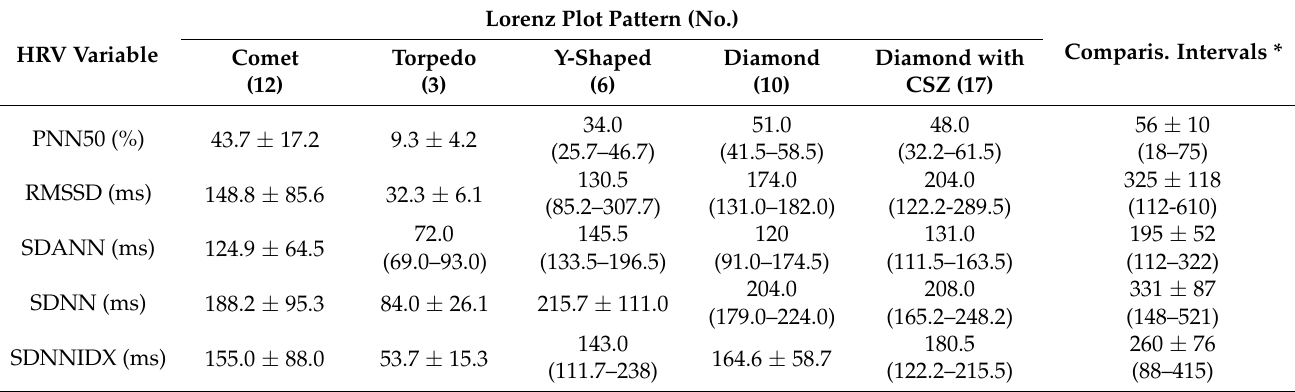
CSZ: central silent zone; HRV: heart rate variability; PNN50: percentage of interval differences of successive NN intervals more than 50 ms;